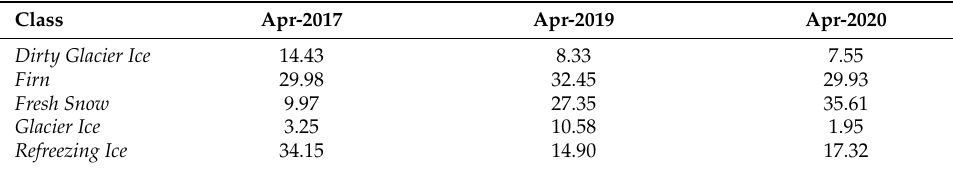
Table 6. Area statistics in % for the months of April in comparison.